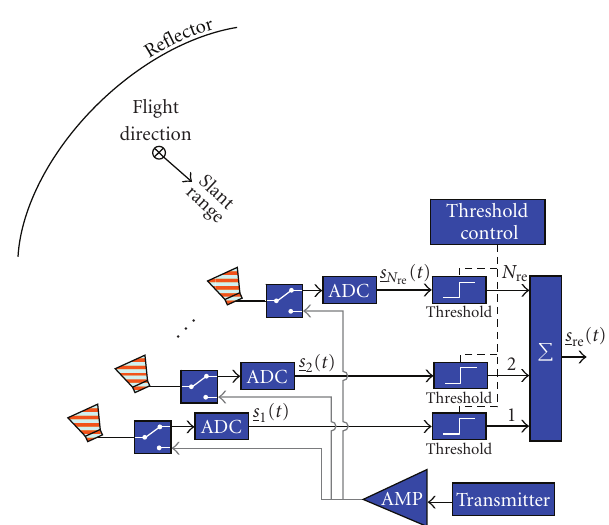
Figure 3: System architecture for reflector system; some compo- nents such as LNAs, mixers, filters etc. are not shown to maintain a clear